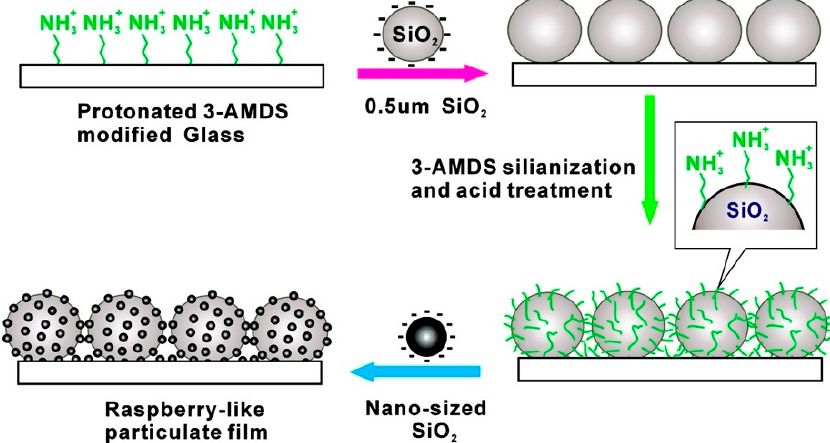
Figure 4. Schematic illustration of the preparation of the raspberry-like nanocomposite coating. Reprinted with permission from [80], Copyright (2007) American Chemical Society.